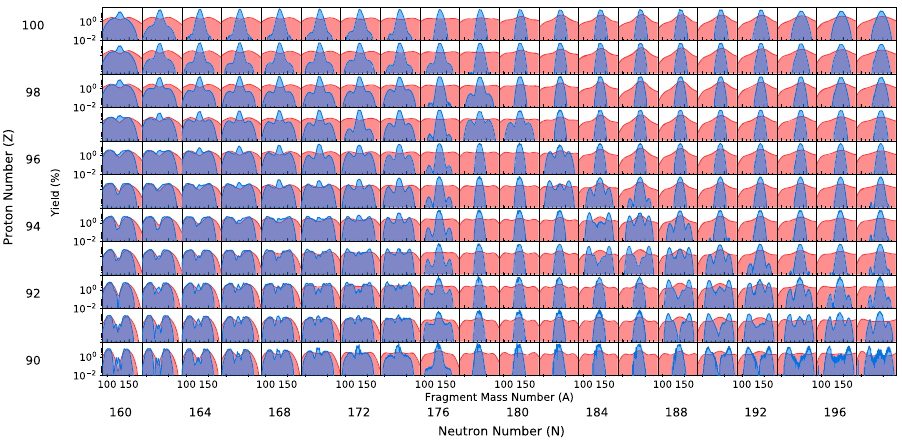
Figure 3. The fission yields predicted for some neutron-rich nuclei of relevance in the r process given recent results which make use of the macroscopic-microscopic theory of FRLDM [28] (red) as com- pared to the data-driven, phenomenological calculations of GEF2016 (neutron-induced fission with an incident neutron energy of 0.1 MeV) [22]